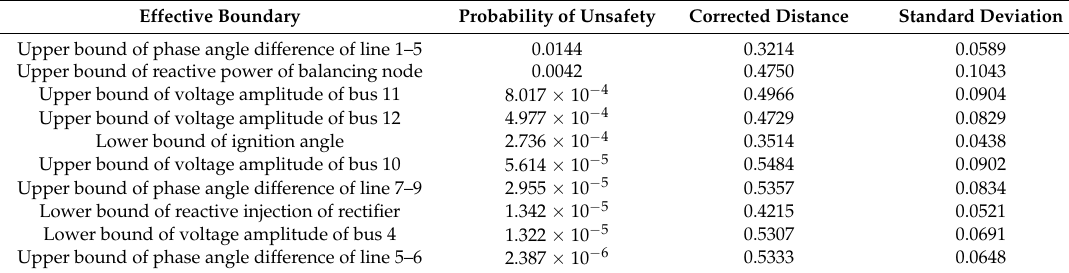
Table 5. Calculation results of the riskiest restraint